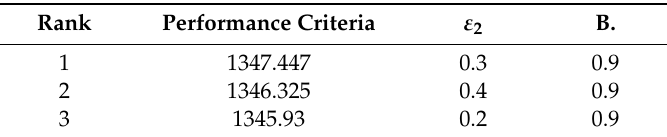
Table 6. Top three parameter sets obtained by the ANN-based parameter tuning approach for AD-RL algorithm applied to PAP.